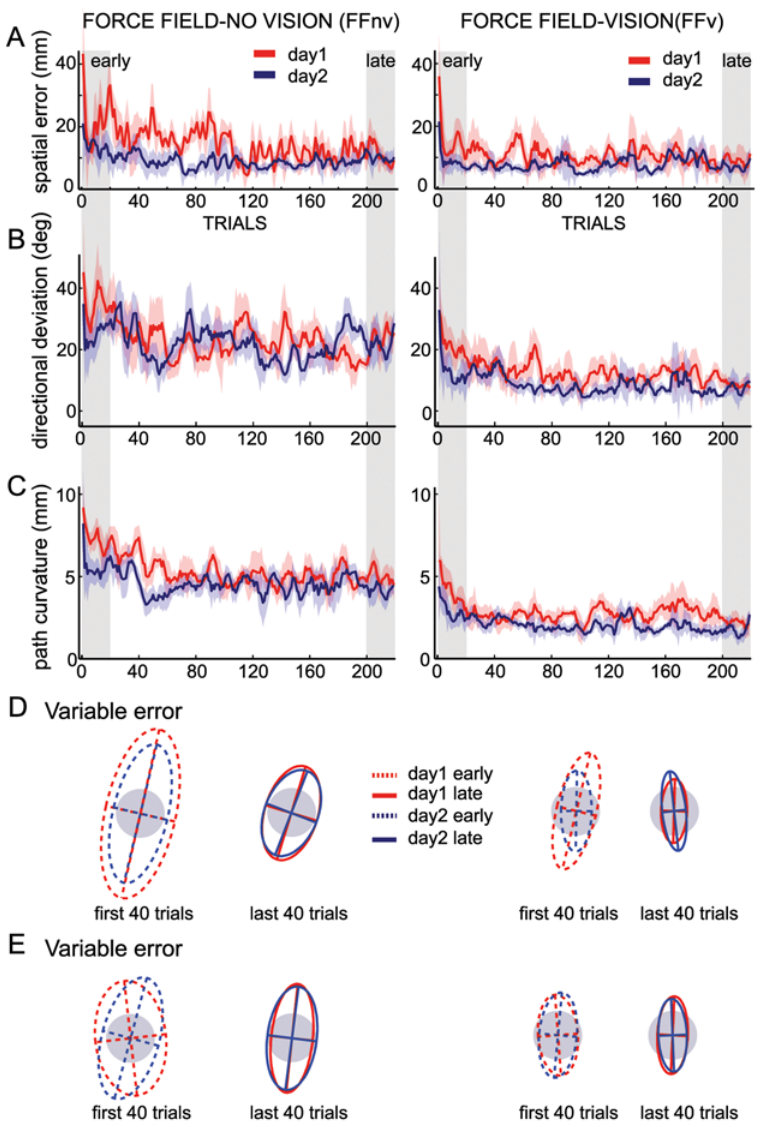
Figure 4. Adaptation to force fields with and without visual feedback. Group data, A–C, Day1 and day2 time courses, showing trial-by-trial means and 6 1 SEM of spatial errors, directional deviation, and path curvature respectively, for force field without visual feedback (left) and with visual feedback (right). Shaded areas correspond to early and late trials used for comparisons. The directional deviation of the first trial in FFnv was the mean across 3 subjects only (the other 3 were aborted trials). D, Endpoint variability ellipses for early and late trials for each group. Each subject’s endpoint position for each trial was subtracted from his mean endpoint position. Gray circle shows the size of the target for comparison. E, As in D but using endpoints taken at near zero